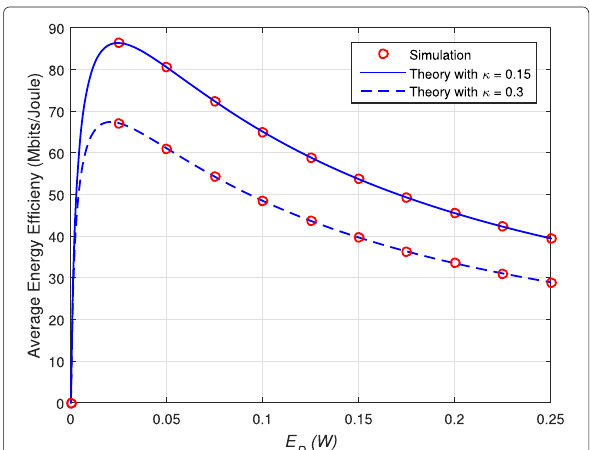
4.4 Average energy efficiency and average spectral efficiency versus E D in the P2P communication The average EE and average SE as functions of E D (W) in P2P communication are depicted in Fig. 10 in case the dis- tance between UE2 and UE3 is 5 km, while in Fig. 11, we compare two cases of the distance between the two nodes, including case 1 is 5 km and case 2 is 10 km, respectively.